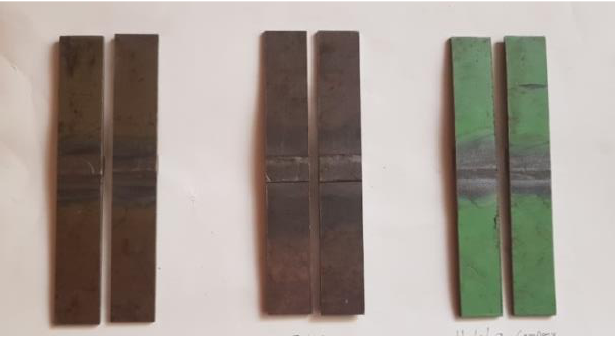
Figure 8: Prepared bending test samples